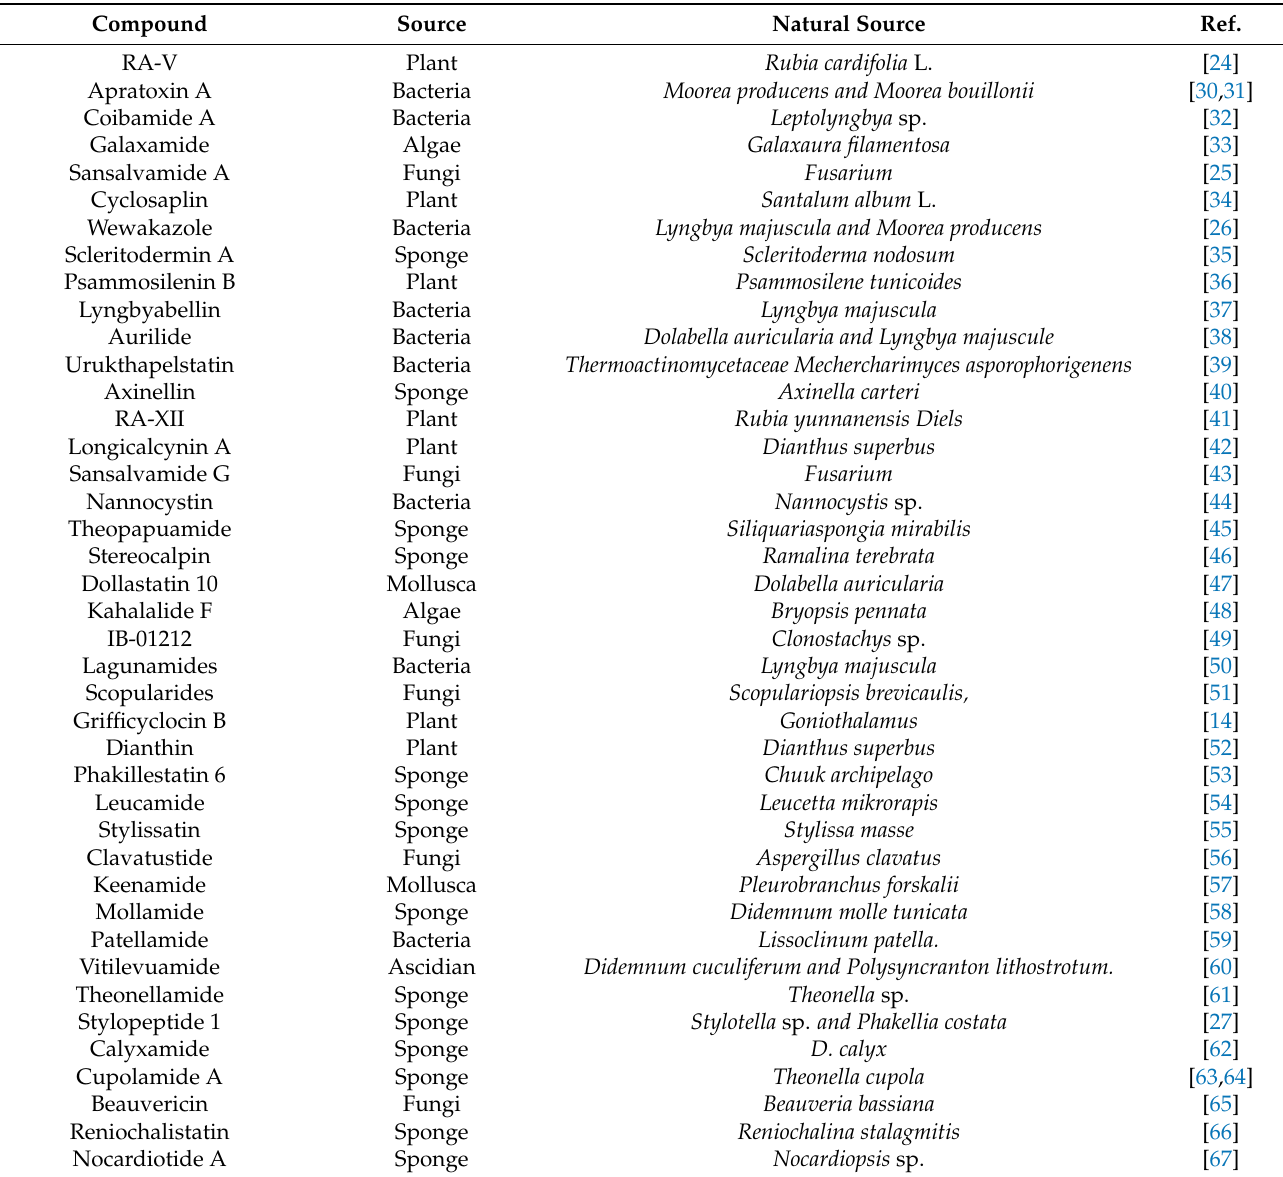
Table 1. Isolation of cyclic peptides from natural